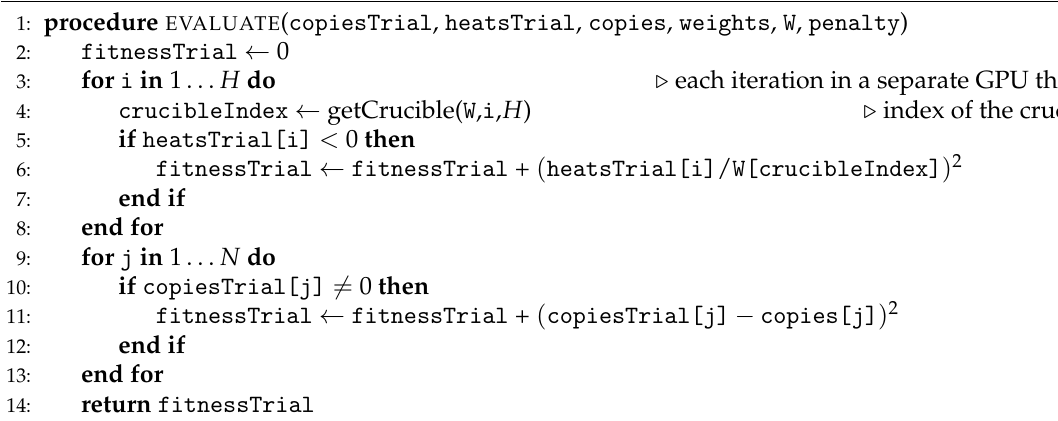
Algorithm 13 Discrete cGA: evaluate().